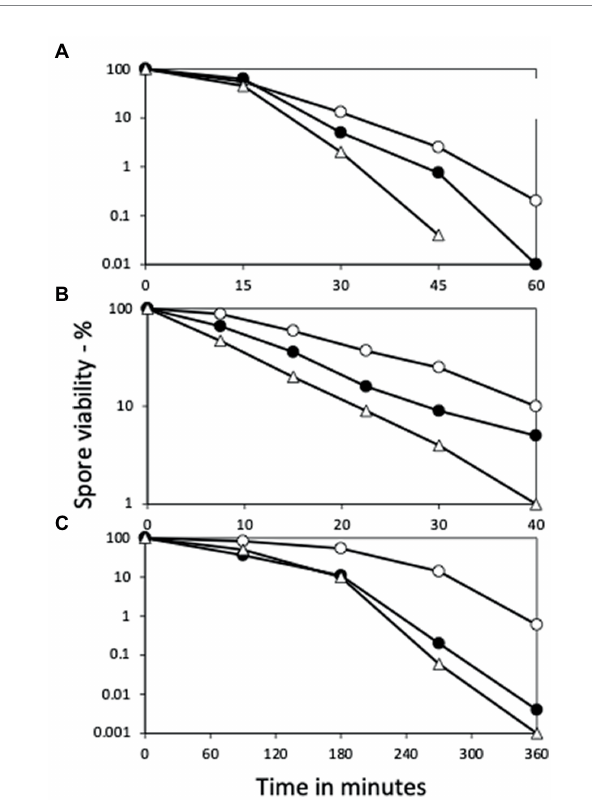
FIGURE 3 Effects of yetF and ydfS mutations on additional spore resistance properties. Spores of strains PS832 (wt), PS4487 ( ydfS ), and 4488 ( yetF ) were treated with (A) H 2 O 2 , (B) formaldehyde, or (C) nitrous acid, and spore survival was measured, all as described in Methods. The symbols used are: ○ – PS832, ● – PS4487 and △ – PS4488. Data are averages from three independent experiments, results varied by ≤ 20%.